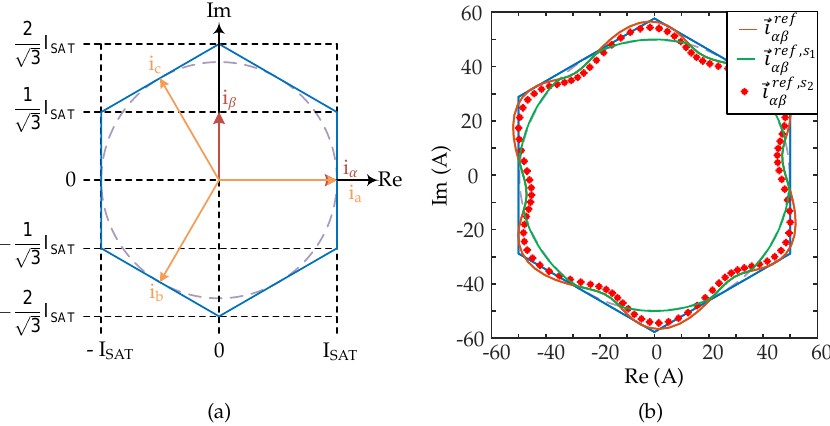
Figure 3. ( a ) Maximum peak limits (blue solid line) and maximum module limit (purple dashed line) in stationary reference frame (StRF); ( b ) Saturation example for maximum module saturator, (cid:126) i ref , s 1 maximum peak current saturator (MPCS), (cid:126) i ref , s 2